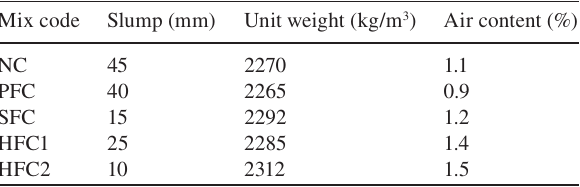
Table 5 Test results of fresh concrete.